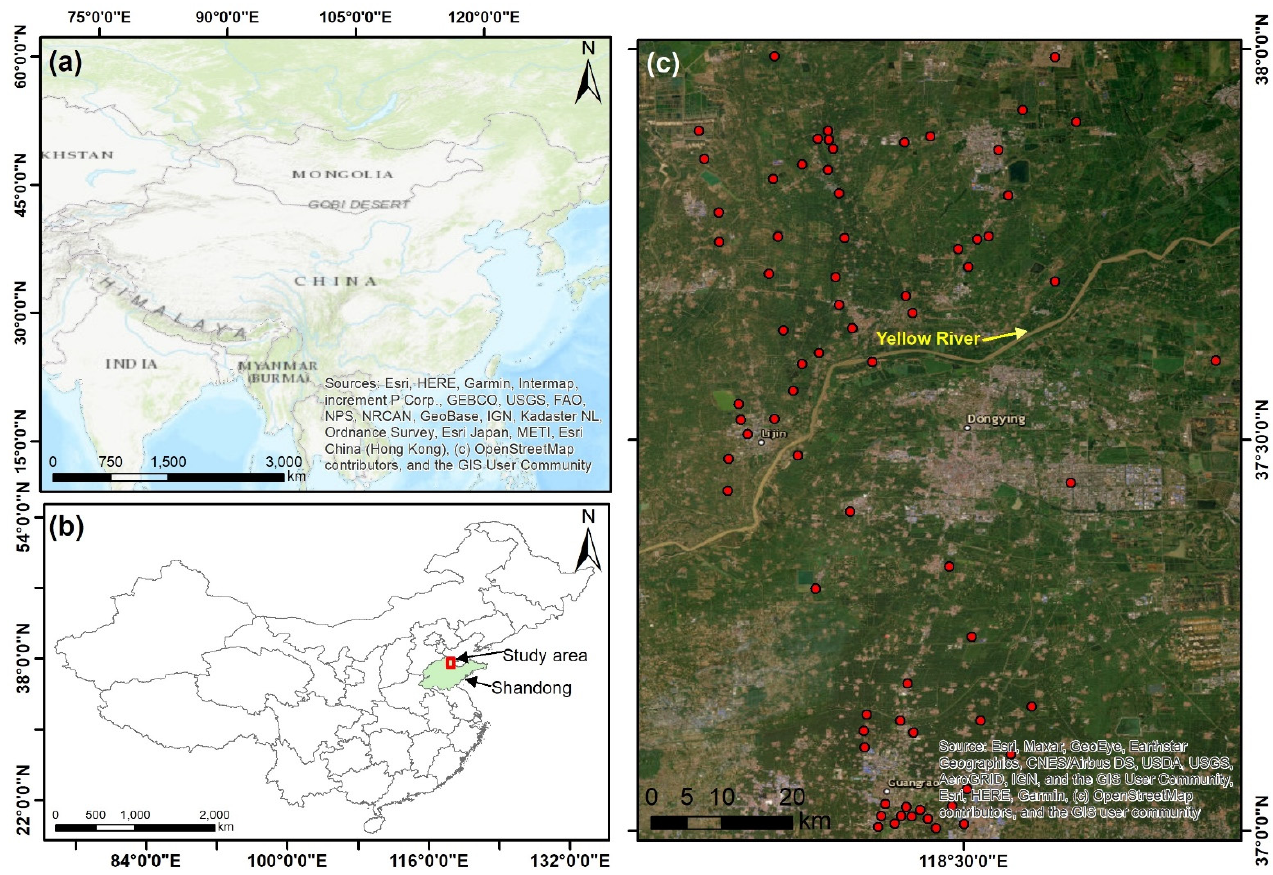
Figure 1. ( a ) Location map of China, ( b ) location maps of study area in red polygon, ( c ) study area that overlain by well locations in red color